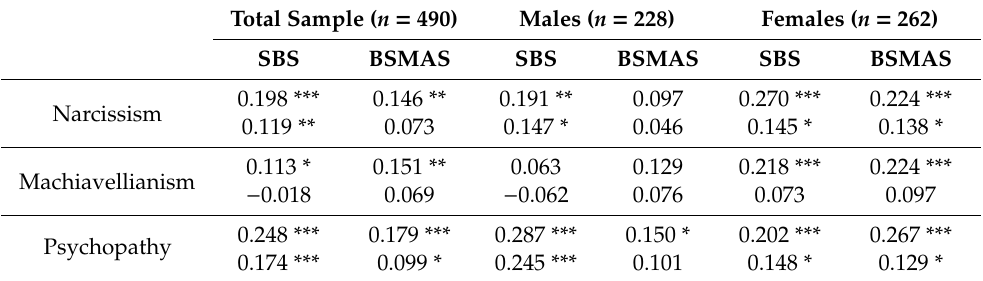
Table 5. Zero-order and partial correlations among the variables of interest for the total sample and for each gender group.